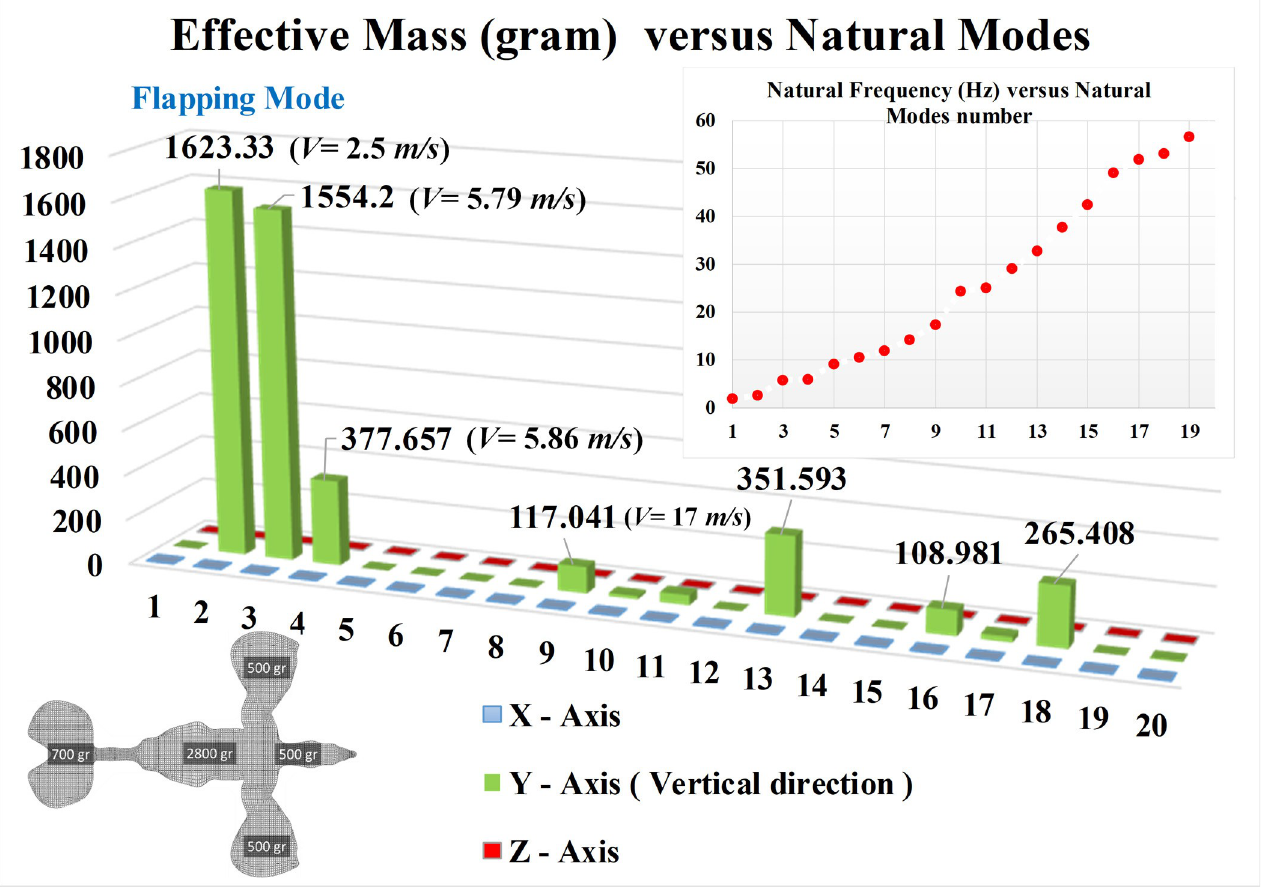
Fig 2. Modal effective mass of Caudipteryx . FE model of Caudipteryx by using modal effective mass illustrates that the most obvious flapping modes are occurred at the speeds of 2.50 m/s and 5.79 m/s. Y-axis is in the vertical direction and X and Z axes are in lateral directions.